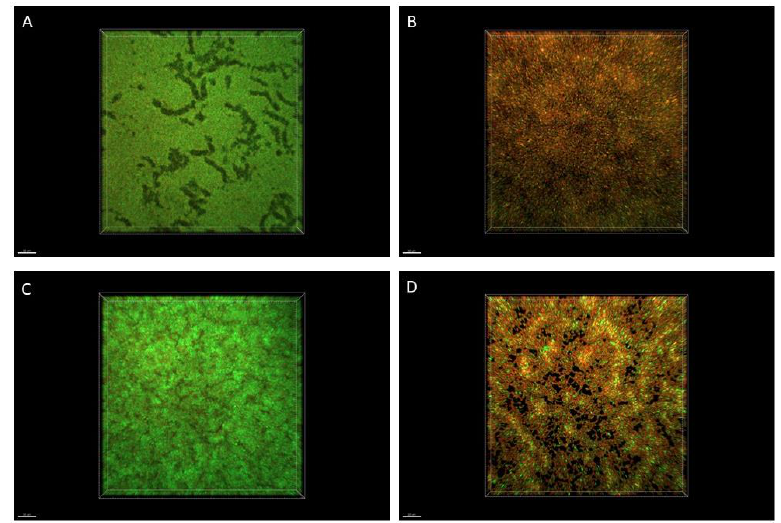
Figure 3. Impact of R-EO on P. aeruginosa ATCC 15442 biofilm. ( A , B ) Pseudomonal biofilm untreated and treated with R-EO in its liquid form, assessed with the modified A.D.A.M. (antibiofilm dressing’s activity measurement) method. ( C , D ) Pseudomonal biofilm untreated and treated with R-EO volatiles, assessed with the AntiBioVol (antibiofilm activity of volatile compounds) assay. The red/orange color shows pseudomonal cells altered/damaged as the result of exposure to R-EO, while green-colored cells are non-altered, viable cells. Moreover, the darker (less green) picture shows that fewer live cells are captured in this particular field of vision.